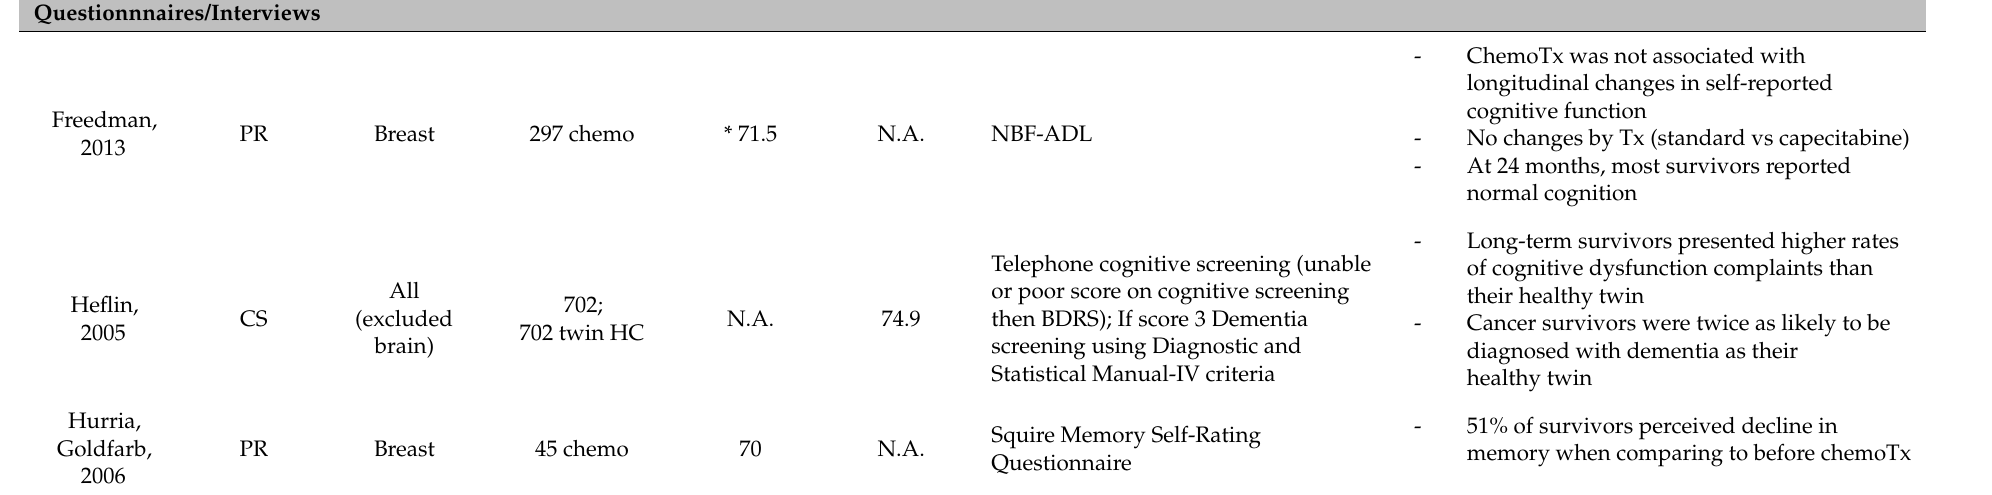
Table A3. Overview of self-report studies in older cancer survivors according to the systematic literature